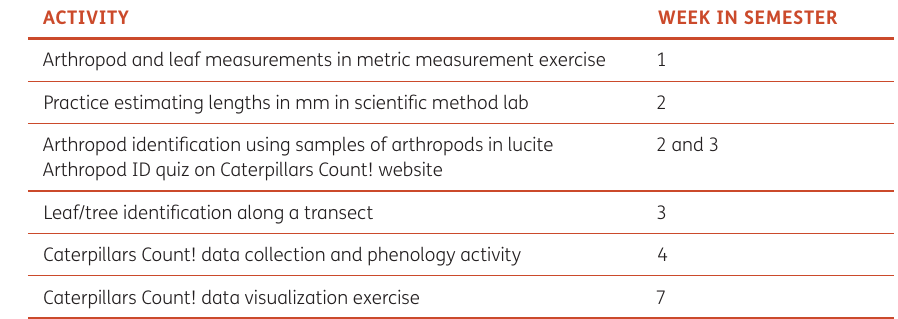
Table 1 Example timeline of activities related to the Caterpillars Count! project at